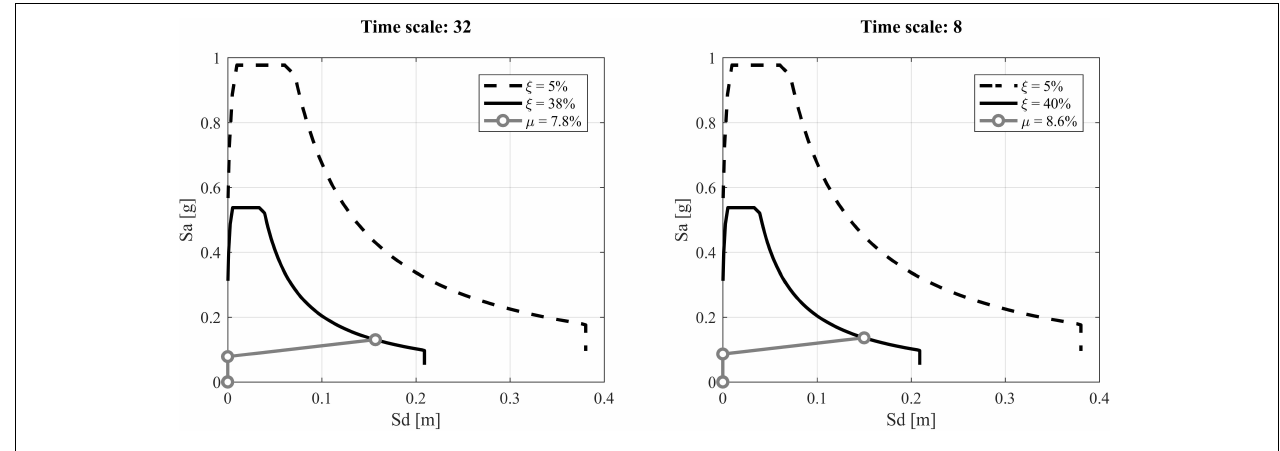
FIGURE 5 | Graphical results of equivalent linear elastic analyses. TABLE 2 | Results of equivalent linear elastic analyses. D max (m) A max (g) ξ eq (#) T sec (s) V max (m/s) µ =